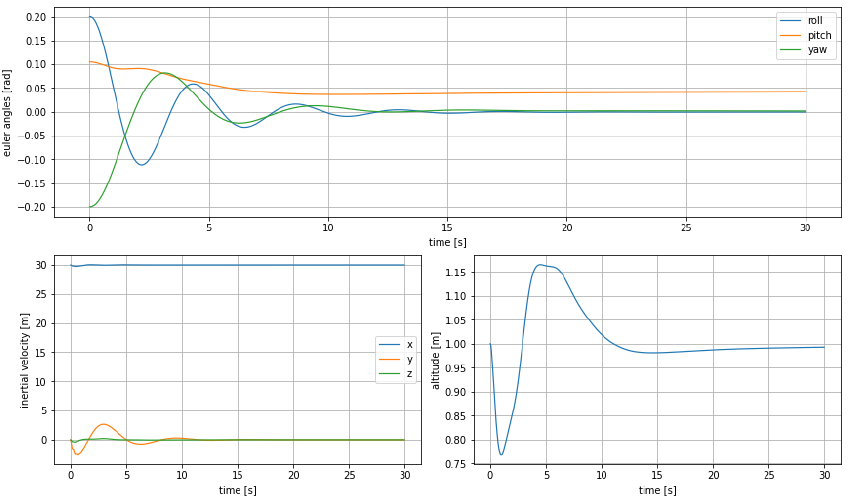
Figure 14. Euler angles ( top ), inertial velocities ( bottom left ) and altitude change ( bottom right ) in altitude change using 6 PID